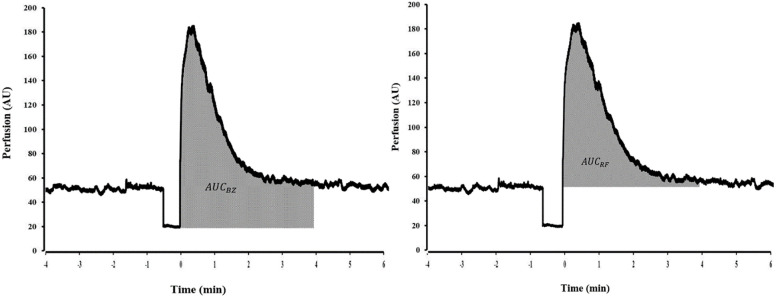
Normalization methods for the area under the curve (AUC).The AUC subtracted from biological zero (AMPBZ) or subtracted from resting flow (AMPRF).